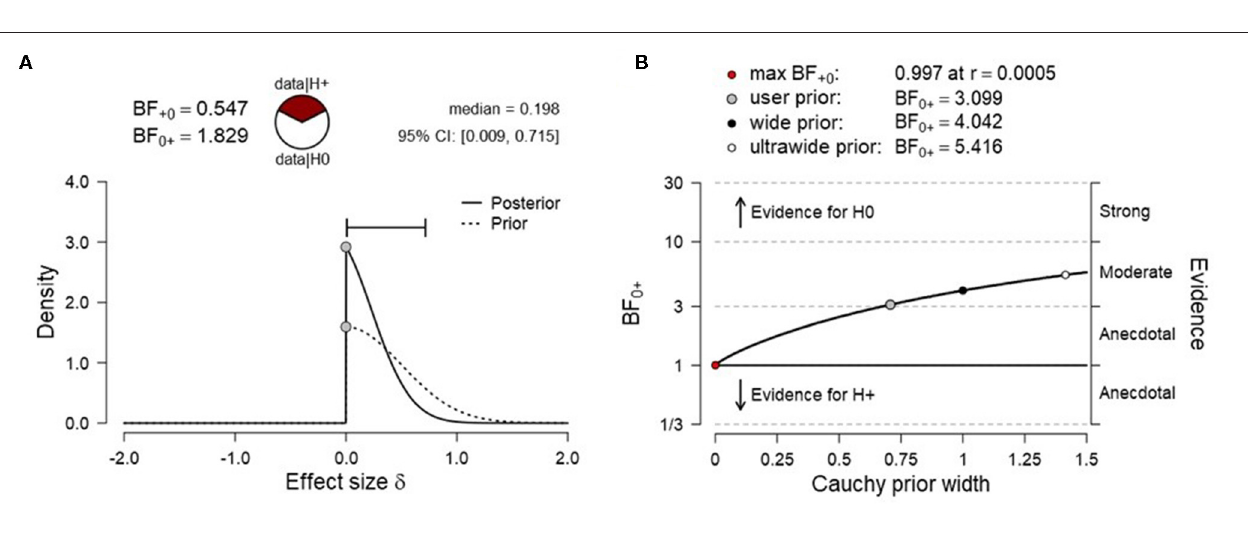
Paired t- tests for high vs. low target level remained inconclusive for P1, P3, and P4, with mean differences indicating a trend opposite to the expected direction (i.e., PSC low > PSC high ). Tests were only significant for P5 before, but not after correction for multiple testing ( Table 4